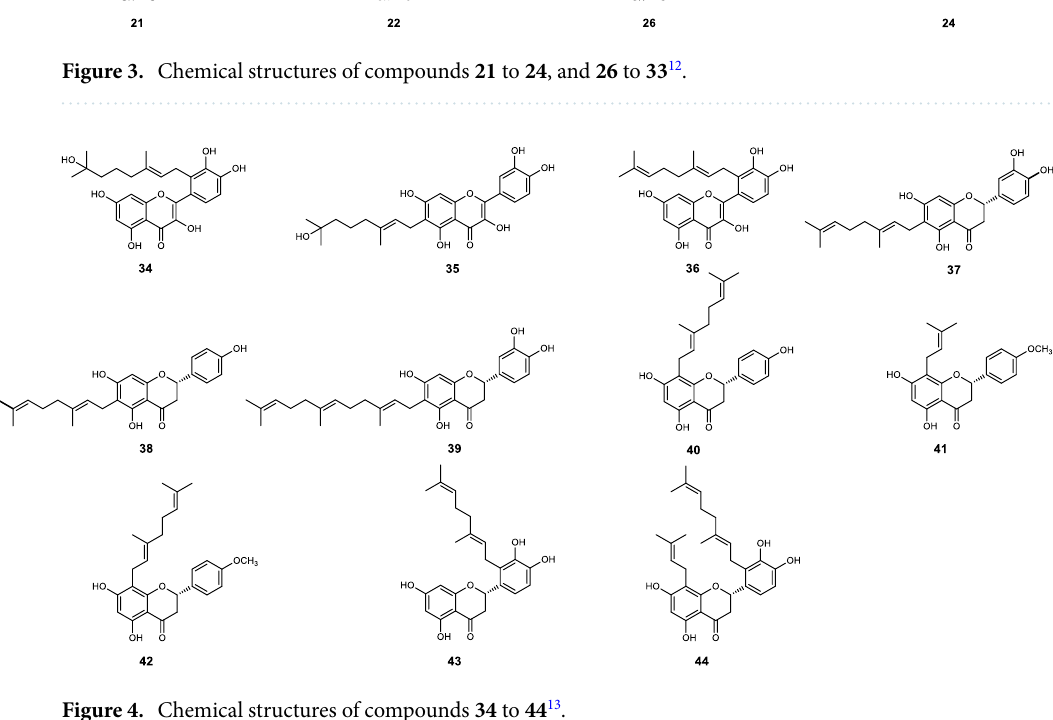
Figure 4. Chemical structures of compounds 34 to 44 13 .